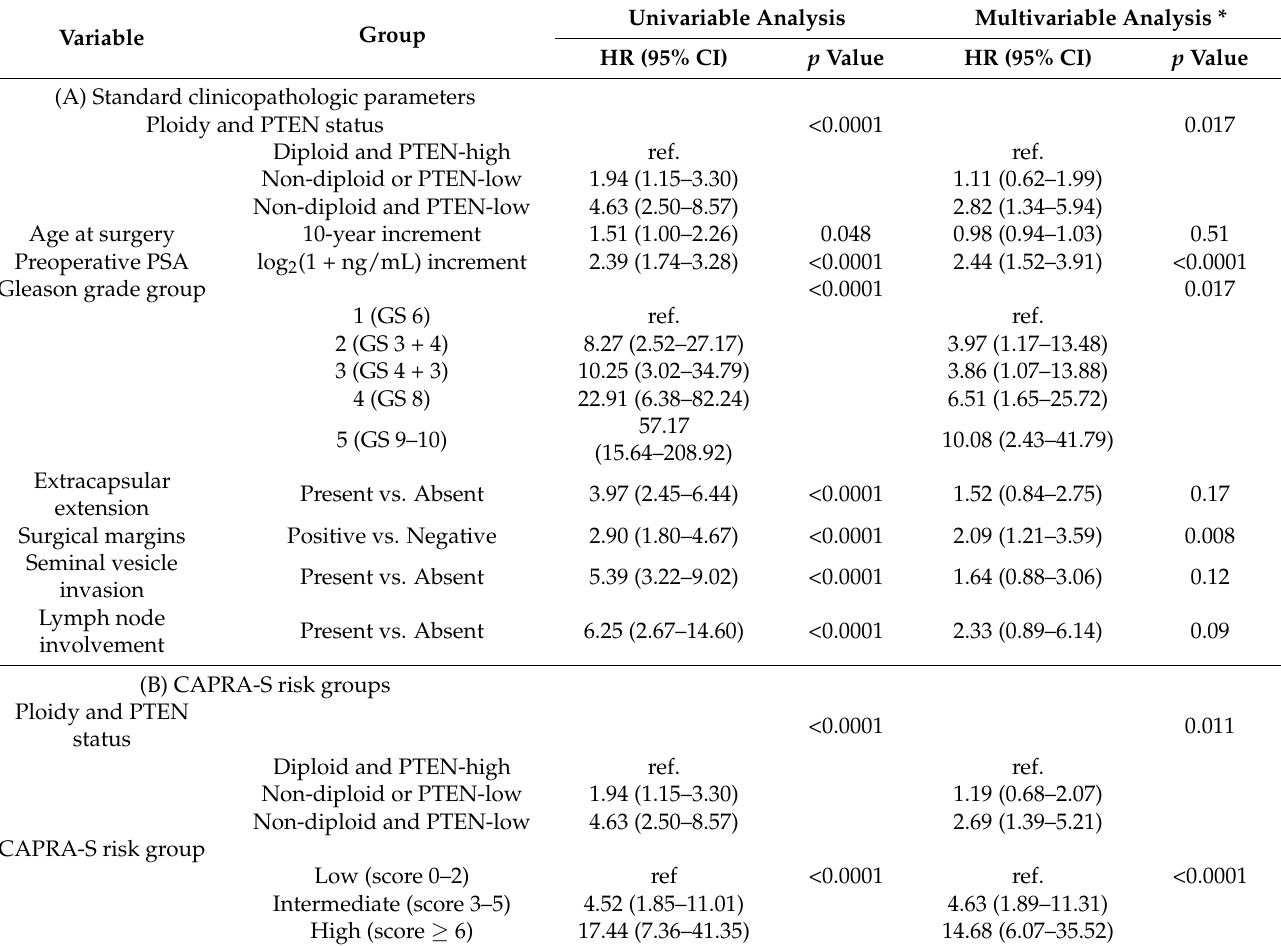
Table 2. Uni- and multivariable analyses of time to biochemical recurrence including Gleason grade groups assessed using routine Gleason